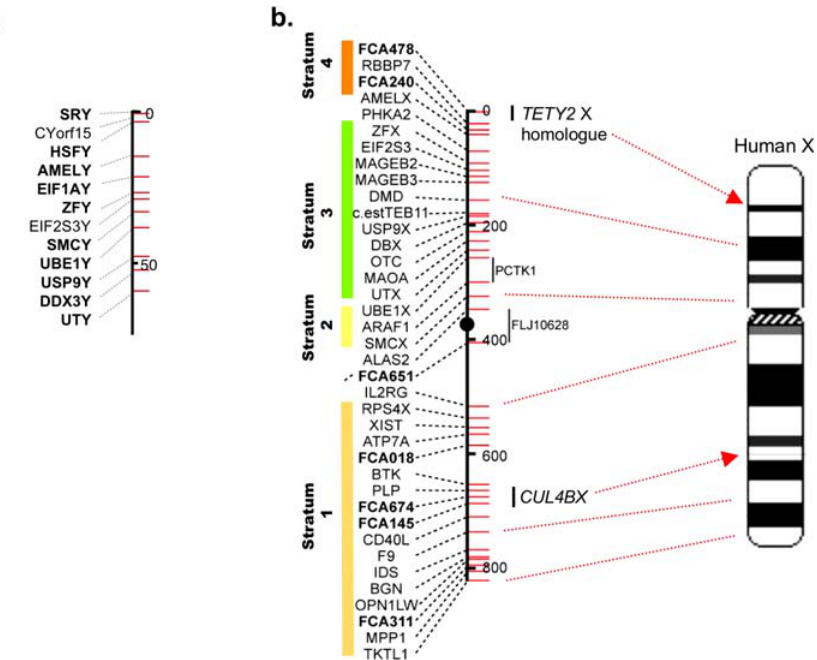
Figure 1. Radiation Hybrid Maps of Feline Y and X Chromosomes (A) Radiation hybrid map of single-copy, X-degenerate genes on the domestic cat Y chromosome. The scale is given in centirays (given in 50 cR 5000 units). Markers in bold are positioned with odds of (cid:1) 1,000:1. (B) Radiation hybrid map of the domestic cat X chromosome, showing the position of X-homologous sequences of TETY2 and CUL4BY . The markers are placed in their most likely intervals relative to the existing feline X chromosome RH map [13]. Red lines with arrows show the comparative position of these genes on an ideogram of the human X chromosome. Additional red dashed lines affirm the overall conservation of gene order observed between the feline and human X chromosomes [13,29,43,44]. Colored blocks on the left demarcate the relative boundaries of four of the five known human X chromosome evolutionary strata [4,26,27,51]. Note that CUL4BX is clearly nested in Stratum 1, consistent with its divergence from CUL4BY prior to the divergence of eutherians, marsupials, and monotremes approximately 230 million years ago [52] (see Table